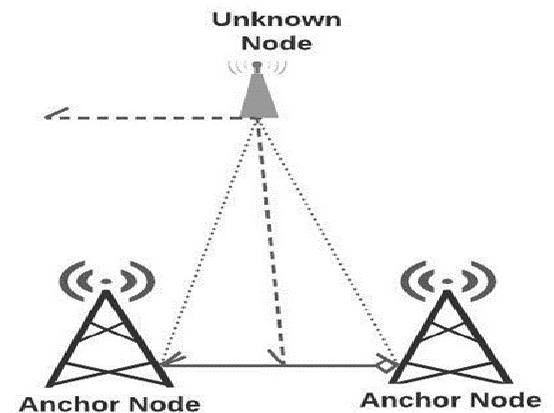
Figure 3. Angle of Arrival.